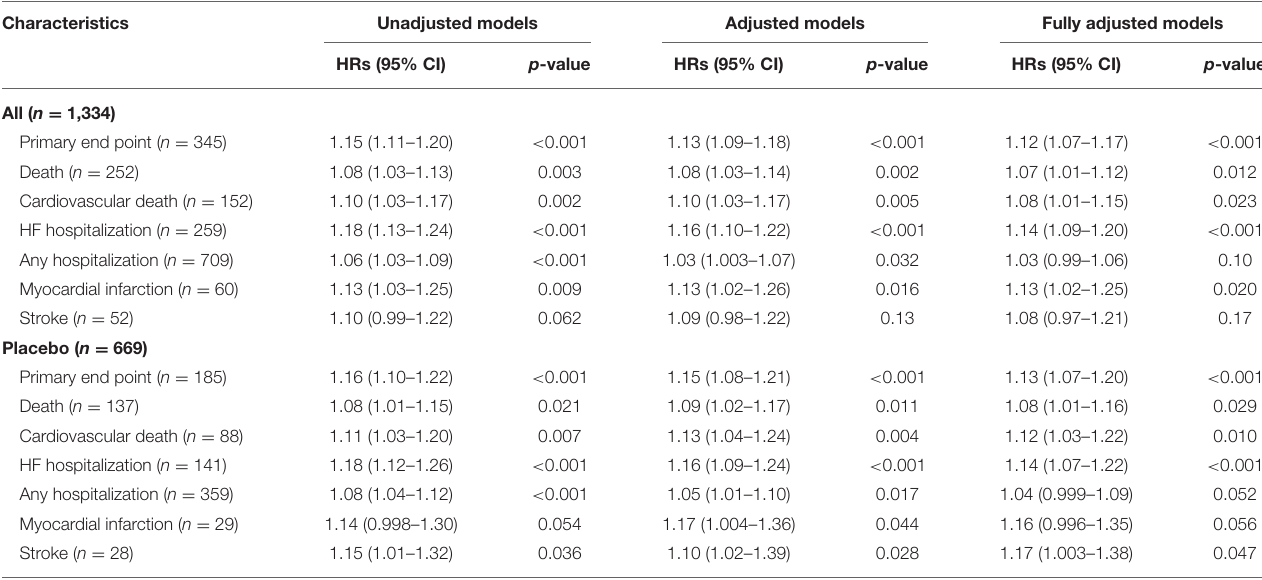
TABLE 3 | Adverse outcomes in relation to the urine microalbumin/creatinine ratio.